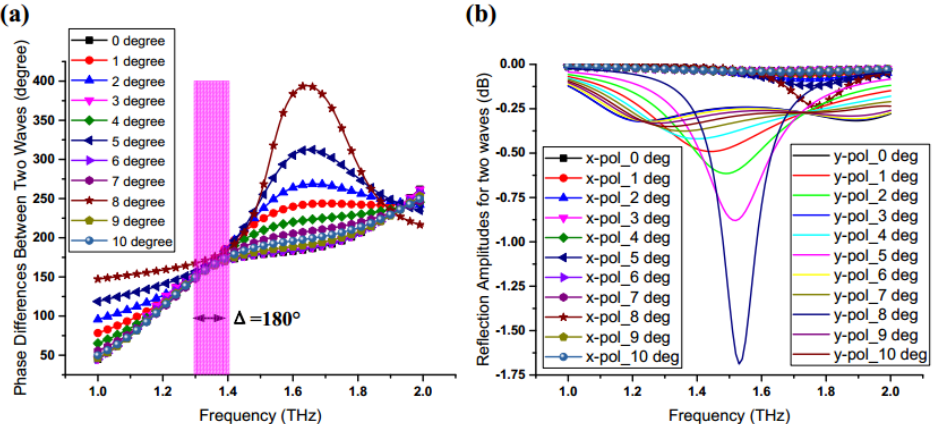
Figure 5. Reflection phase differences and the reflection amplitudes between x- and y-polarized waves under the illumination with different incident angles: ( a ) the phase difference curve varies with changing the incident angle and the operation bandwidth reduces to the range of 1.3 ~ 1.4 THz; ( b ) reflection amplitudes of x- and y-polarized waves change with variation in the incident angle in the range 0 ~ 10 degrees.